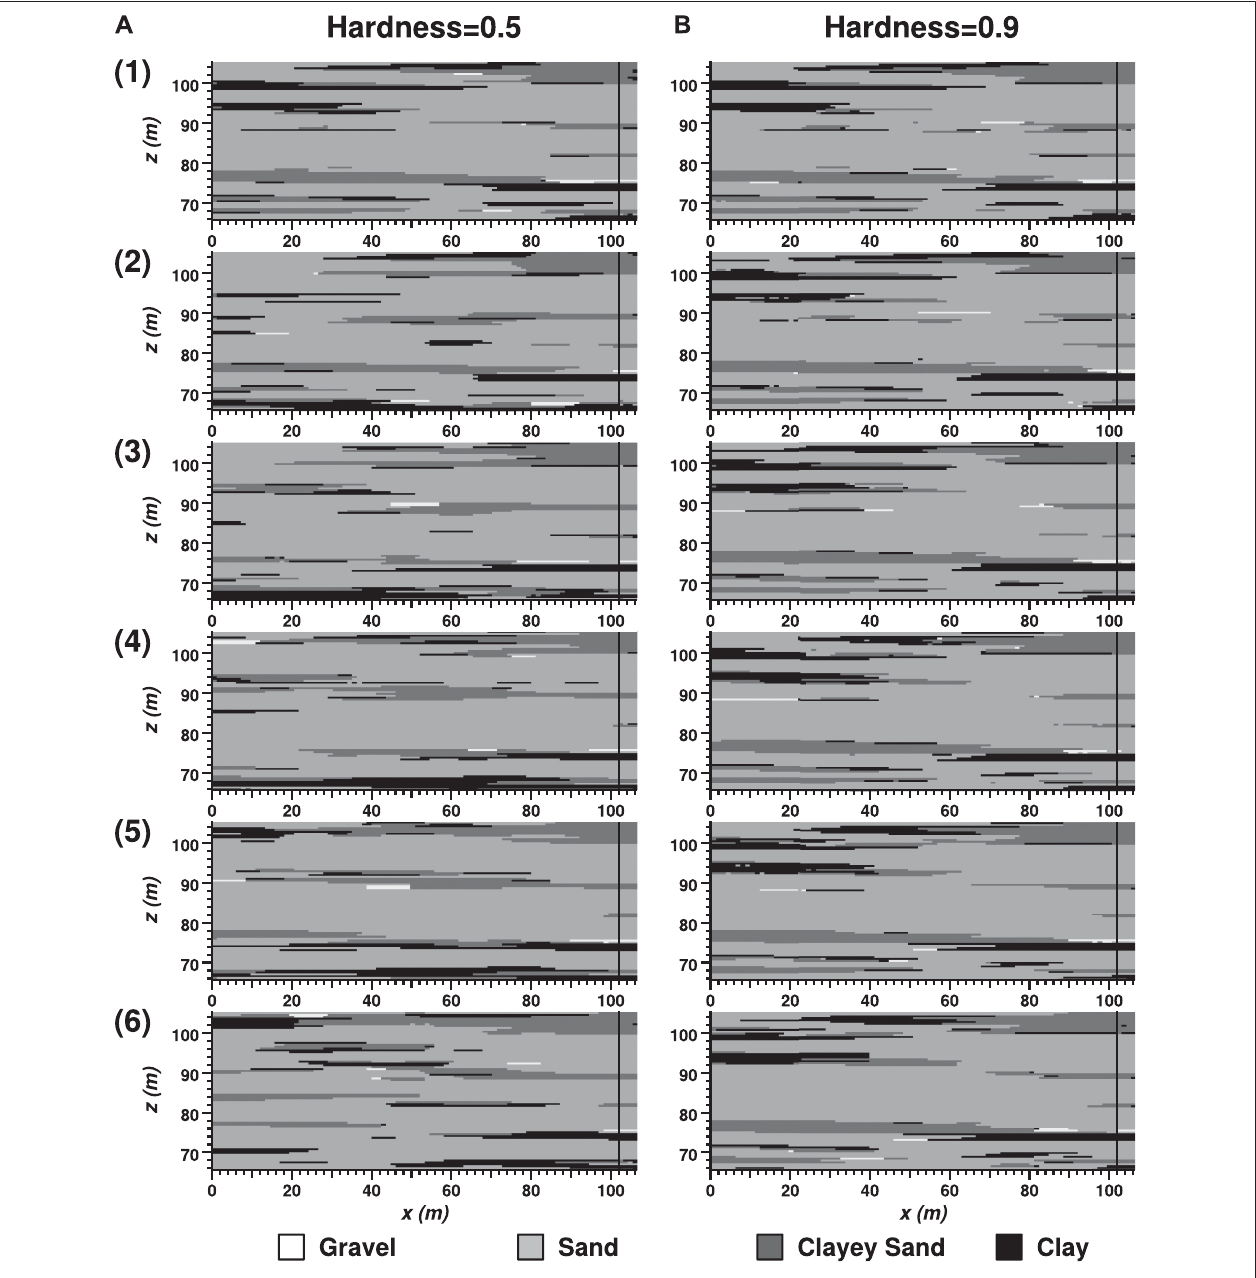
FIGURE 6 | Six successive realizations where the previous realization serves as soft conditioning, with hardness set for case (A) at 0.5 and case (B) at 0.9.